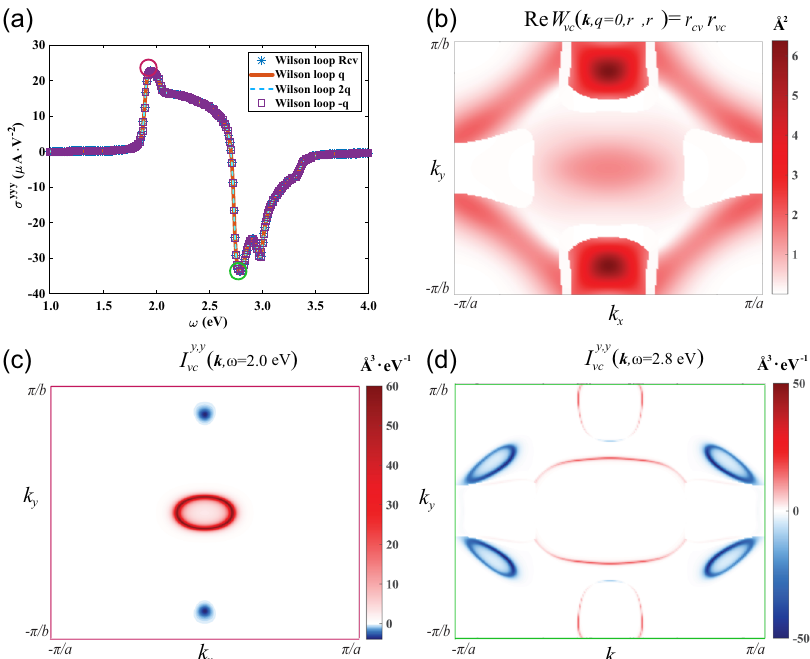
Fig. 4 Shift current conductivity and the k -space distribution of the related quantities in monolayer GeS. a Shift current conductivity − q σ yyy ω ð Þ calculated by the Wilson loop approach with two bands across the gap. R cv denotes the original shift vector formula and q , 2 q , represent the formula using the imaginary part of Wilson loop W mn k ; q ; r ; r ð Þ with different q values. b k -resolved absorption strength r y cv r y vc corresponding to quantum metric g yy cv in the fi rst Brillouin zone. c , d k -resolved shift current strength I y ; y vc k ; ω ð Þ at ω ¼ 2 : 0 and ω ¼ 2 : 8 eV using the Wilson loop approach,